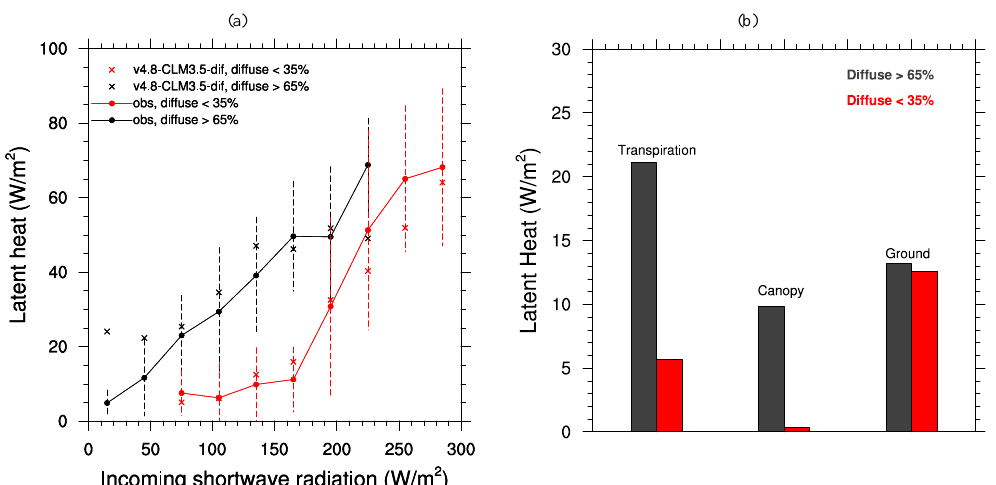
Fig. 6. Latent heat response (observed and simulated) to diffuse/direct light conditions at the Hyyti¨al¨a site. a) Latent heat evolution as a function of incoming shortwave radiation for predominantly diffuse light conditions (black) and predominantly direct light conditions (red). The points represent the mean latent heat for specific radiation bins based daily means over the period 2002-2005 restricted to spring and summer (growing season). The standard deviation of the observation is also shown. Diffuse and direct conditions are defined as diffuse light fraction above 65% and below 35%, respectivelly. b) Individual evapotranspiration components in the model and their sensitivity to light conditions. The plotted values are averaged over the 100-200 shortwave radiation range using the same underlying data as for a). Table 2. Squared correlation ( R 2 ) between modeled and observed (E-OBS) 2-meter temperature. Time series are domain-averaged over eight different regions as defined in Fig. 4. Correlations are based either on monthly or daily means in both cases considering only data between June and